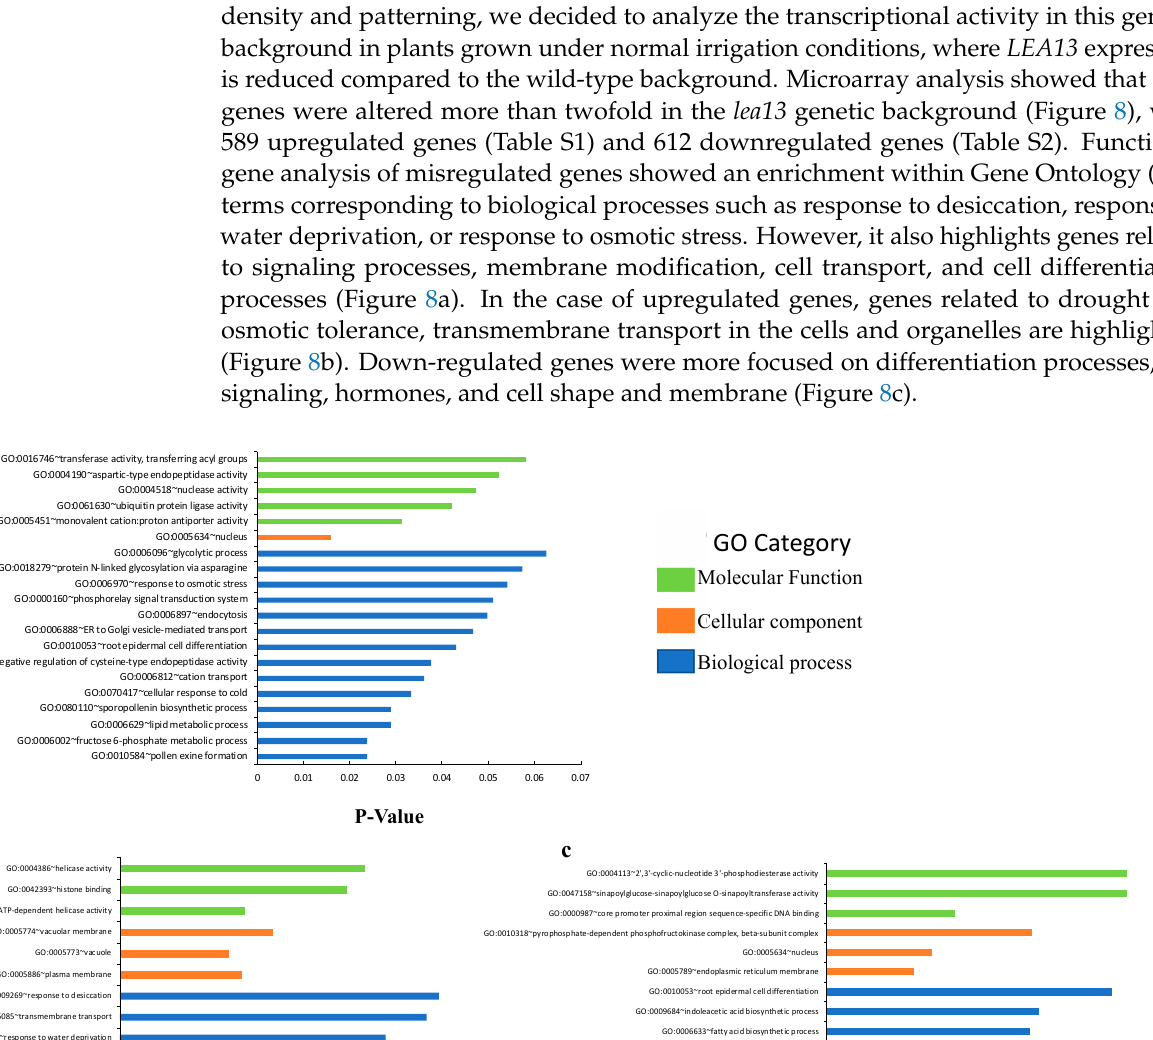
Figure 7. Analysis of the gene expression of lea13 , lea30 and markers of stomata development in the 35S:LEA73 genetic background. Cotyledons of seedlings 15 days after germination (dpg) growth under normal irrigation conditions were analyzed. Y-axis: relative expression (2 −ΔΔ CT ). * Data represent samples significantly different p <0.05. All tests were per- formed using 3 biological and technical replicates.